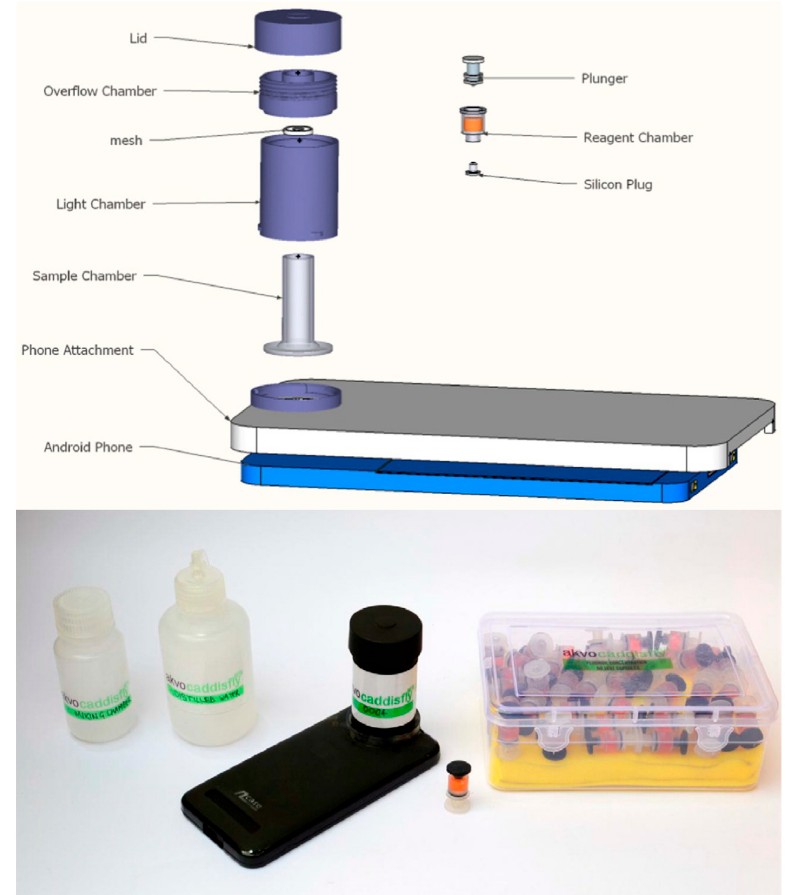
Figure 6. Schematic and picture of the smartphone-based fluoride test proposed by Levin et al. Adapted from [25], http://dx.doi.org/10.1016/j.scitotenv.2016.01.156 under the Creative Commons